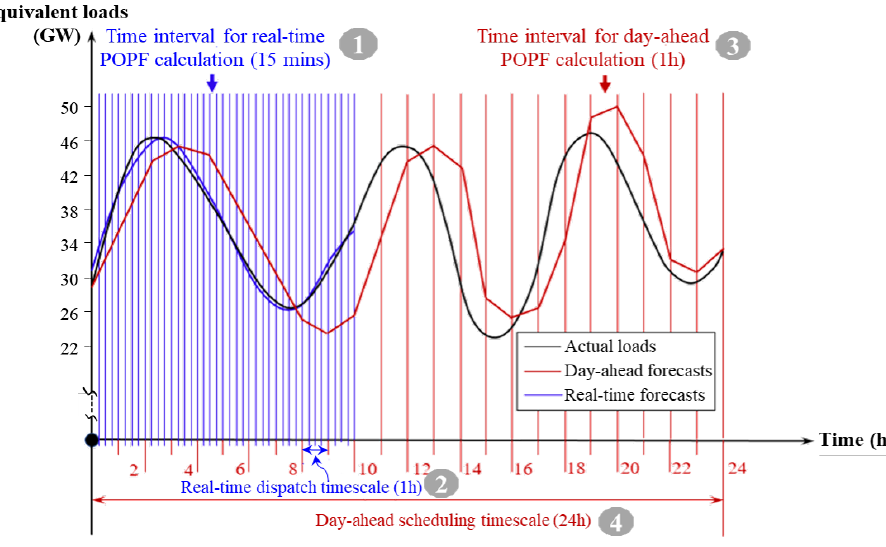
Figure 5. Applications of a discrete time optimal power flow for continuous problem. Compared with real-time dispatch, the timescale for day-ahead scheduling (24 h) and its LI (1 h) are longer, resulting in larger forecast error and a more approximate